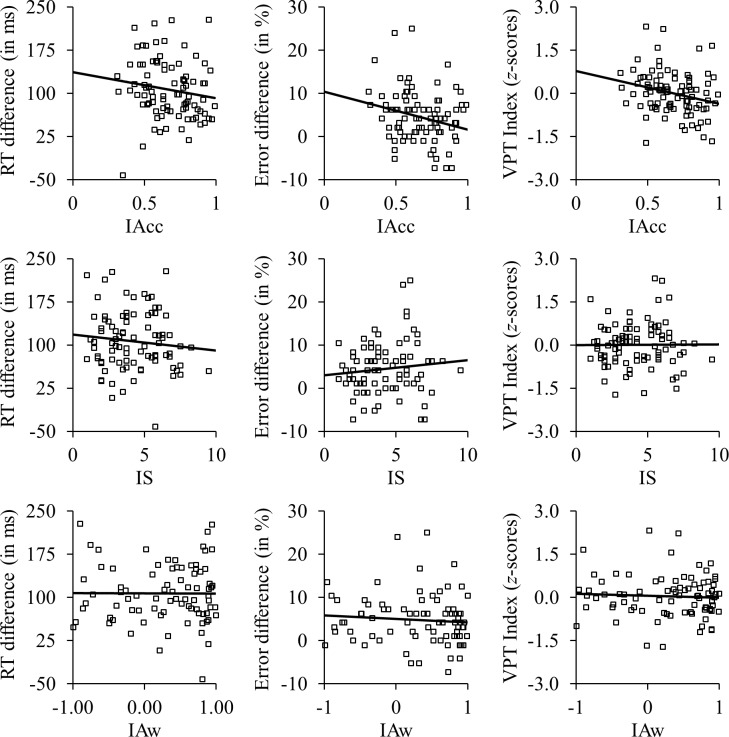
Correlations between interoception and VPT.Raw data and correlations between IAcc (top row), IS (middle row), and IAw (bottom row) with VPT speed (left column), accuracy (middle column), and overall performance (right column).